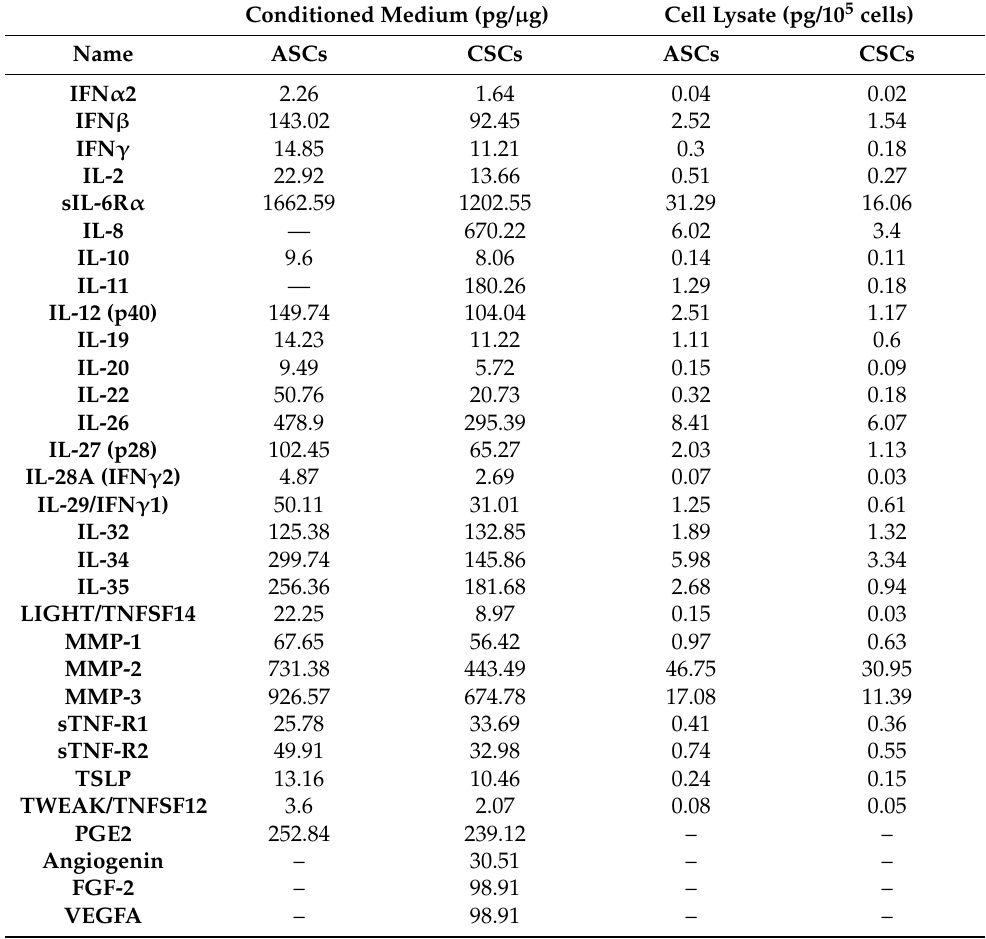
Table 5. Key cytokines and growth factors secreted by ASCs and CSCs.